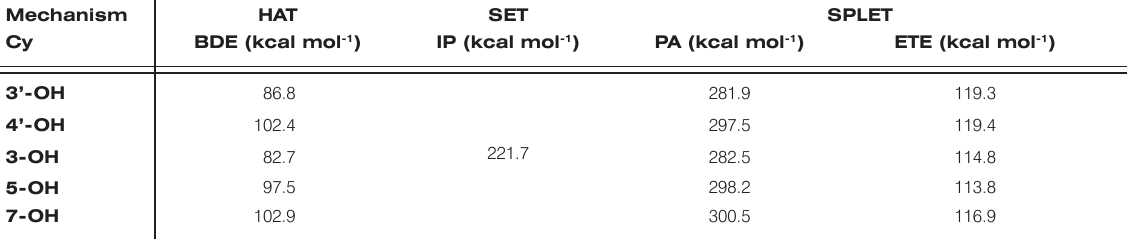
Table 2. Calculated parameters of the three possible radical-scavenging mechanisms for the delphinidin radicals (ROHF/6-31+G(2d,p) level). Mechanism